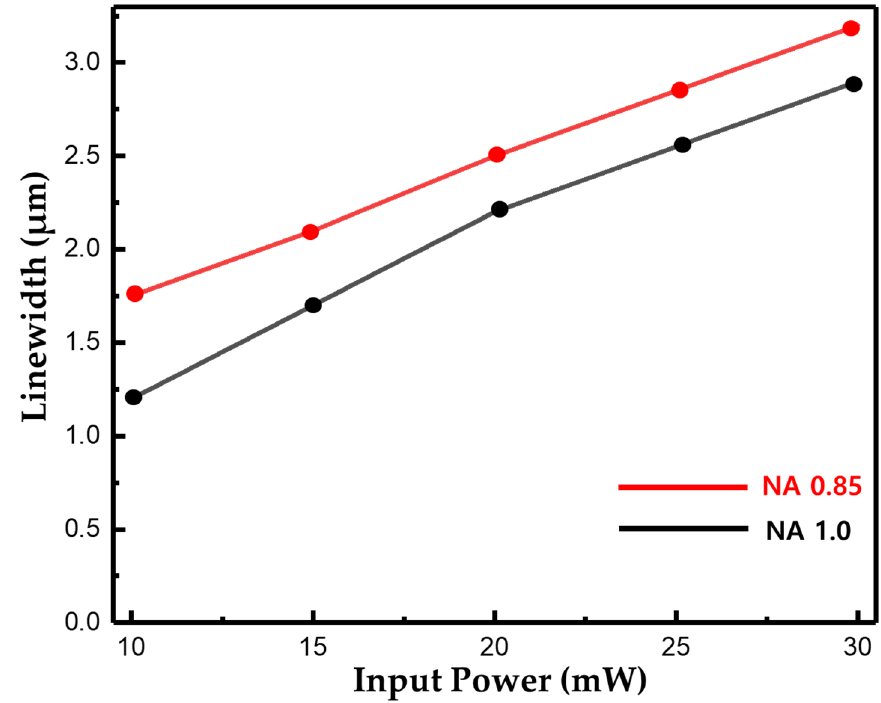
Figure 7. Relationship between the laser power and linewidth.